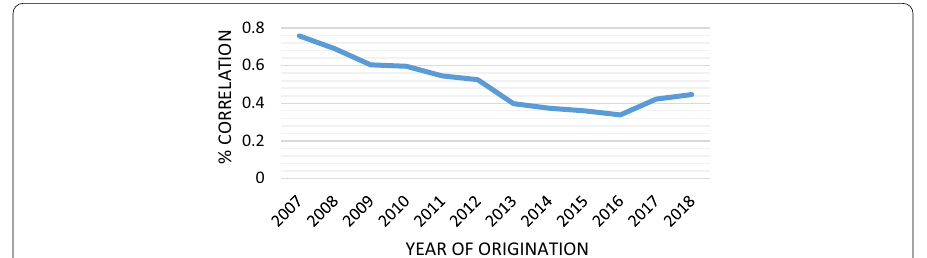
Fig. 3 Correlation between FICO score and the LC rating grade. Notes. This graph displays the association